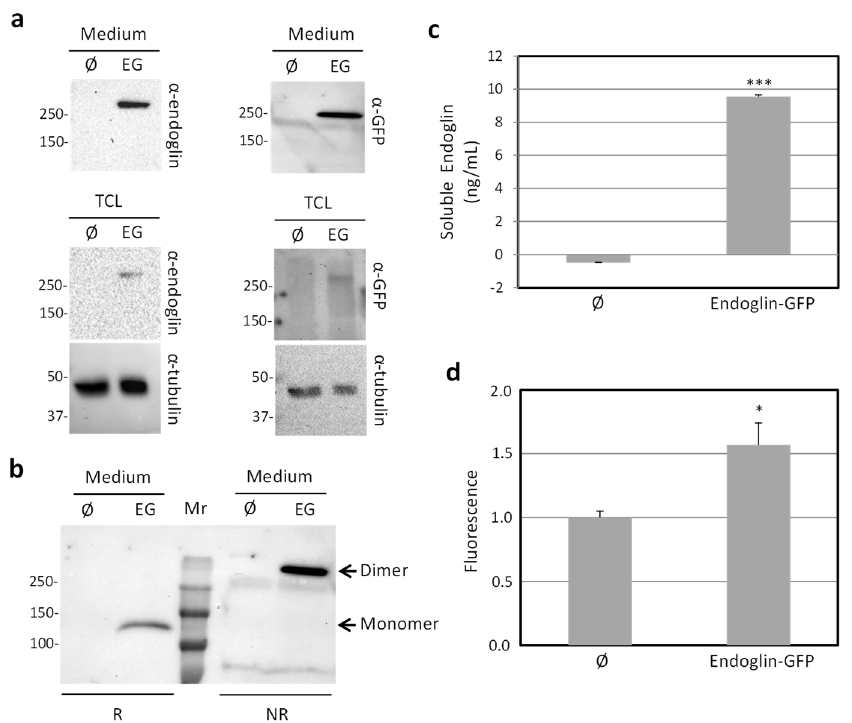
Figure 4. Expression of endoglin–GFP fusion protein by cell transfectants. CHO-K1 cells stably trans- fected with pEGFP–N1/Eng.EC (EG) or an empty vector (Ø) were cultured for 3 days. ( a , b ) Western